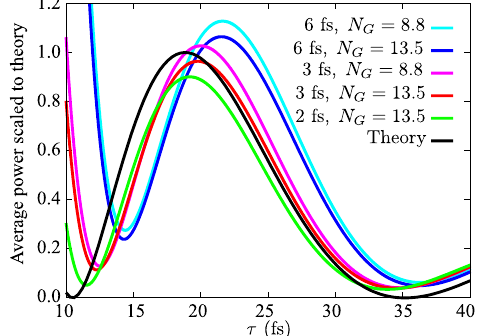
FIG. 6. Ensemble-averaged power of the monochromatic seed obtained from simulation, scaled to the theoretical predicted amplitude (41). We have varied both the electron beam temporal duration and the undulator length to produce the L pulse and N G listed in the key. We have used a flattop electron beam profile to more accurately determine L pulse ; more realistic distributions can be expected to yield power deviations from the theory by a factor of 2. The position of the first maximum linearly increases as the pulse duration increases, and therefore varies by a few femto-